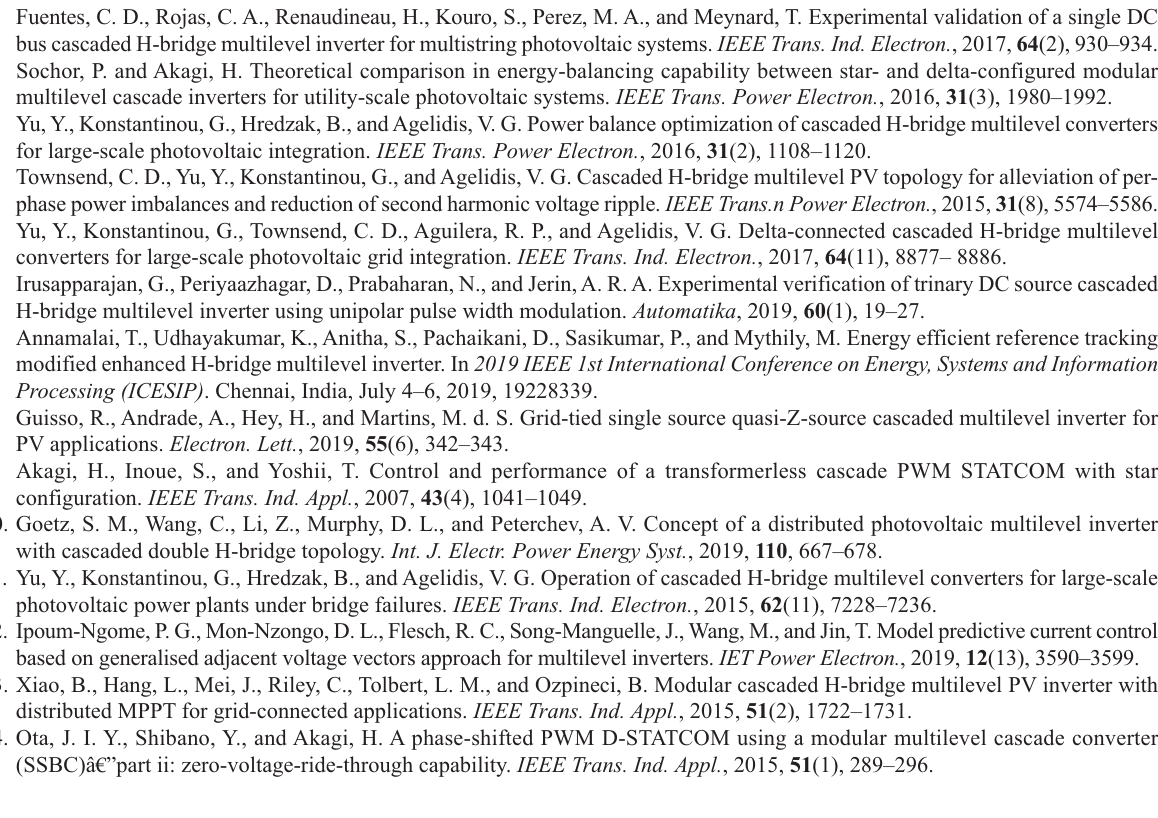
Fig. 18. Generated voltage in Phase A without aa filter.